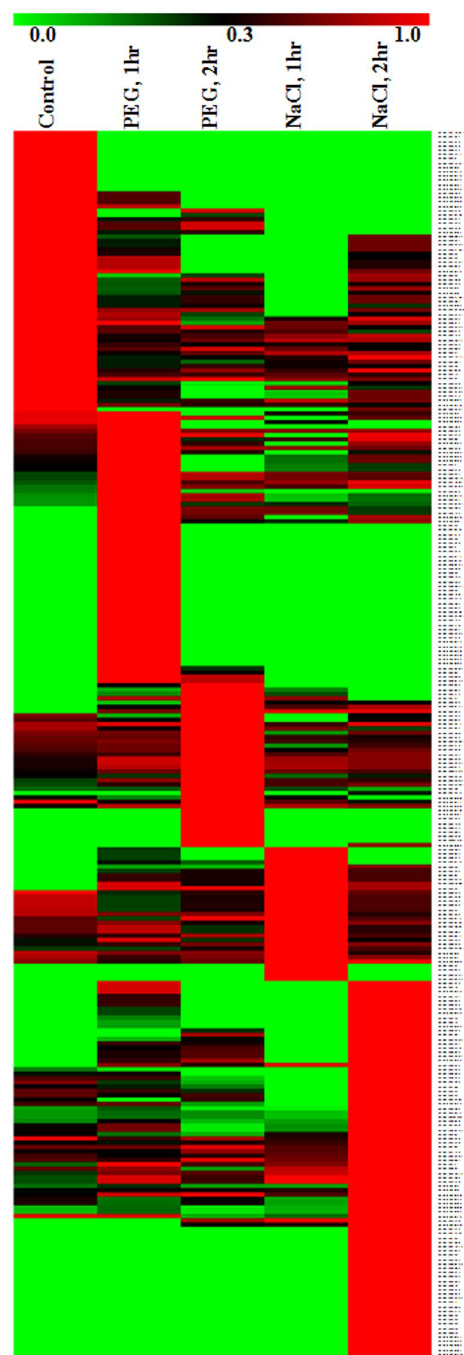
Figure 3. Expression profiling of miRNAs at different stages of treatments with PEG and salt. Heat map representing fold expression of 284 miRNAs based on their normalized reads per million (RPM) values. RPM values of a miRNA were normalized by the highest RPM value of that particular miRNA in any library to have fold expression value of a miRNA at a time point. The miRNAs were clustered according to their normalized